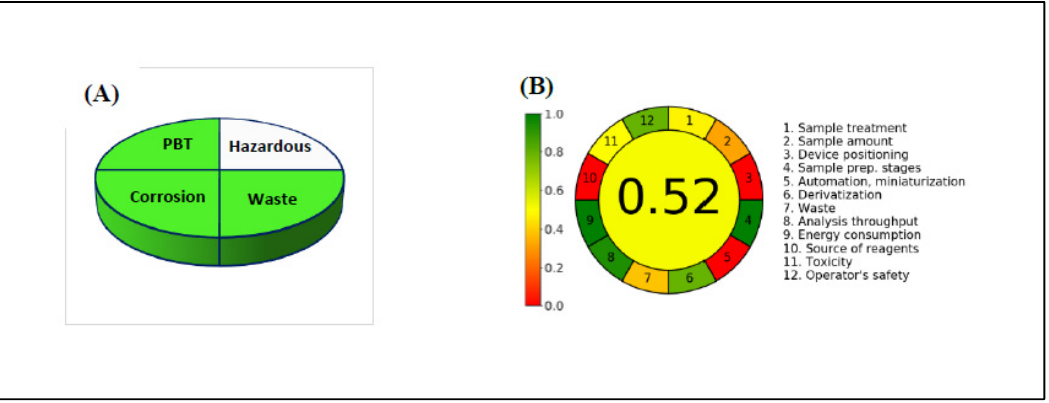
Figure 8. Results of ( A ) NEMI and ( B ) AGREE analysis for the developed method.